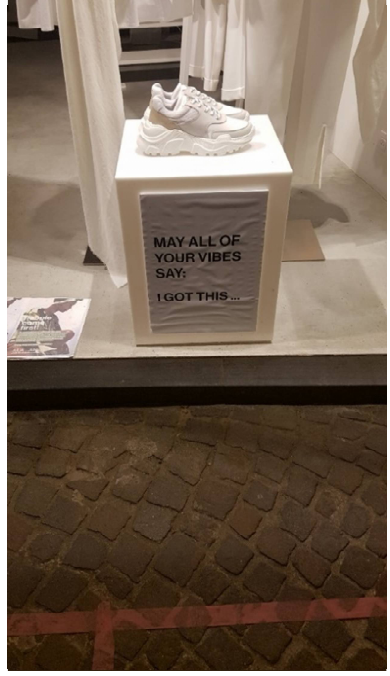
Figure 6. May all of your vibes say: I got this…